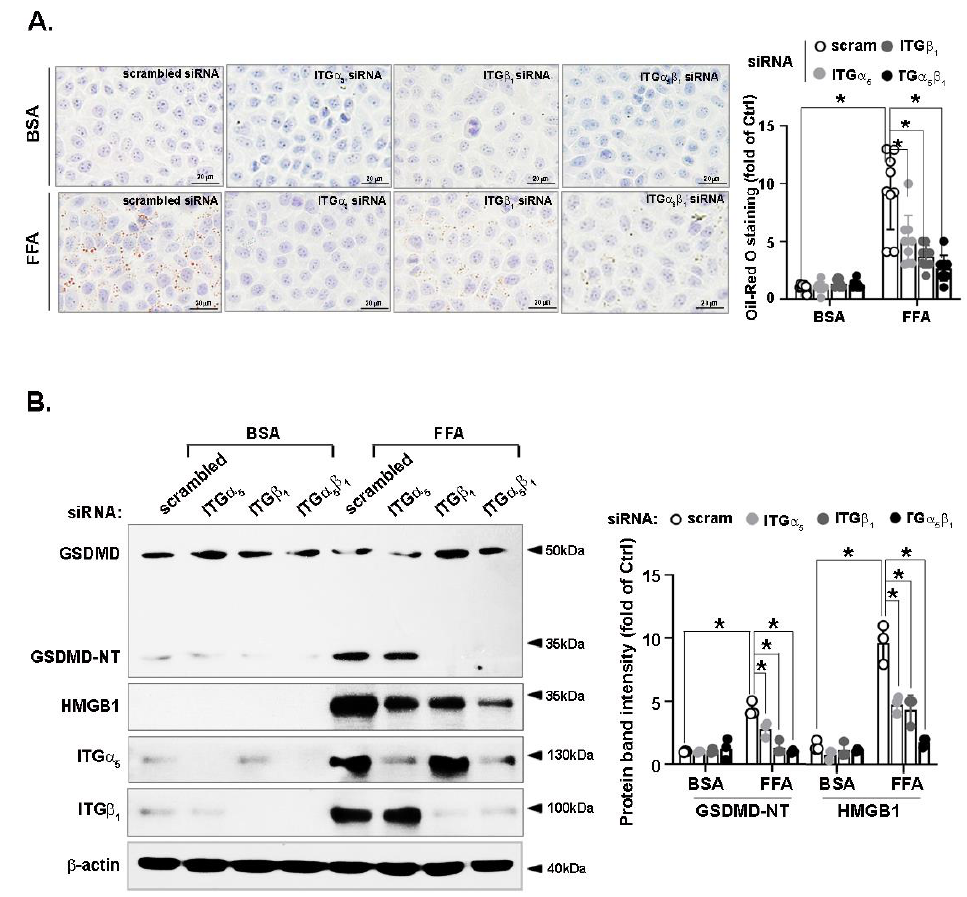
Figure 7. Effects of integrin α 5 β 1 on FFA-induced lipid accumulation and pyroptosis in hepatocytes. LO2 hepatocytes were transfected with scrambled, integrin α 5 , integrin β 1 , or integrin α 5 + β 1 siRNA, then incubated with FFA (1 mM). ( A ) Prior to harvest, LO2 hepatocytes were stained with oil red O for 1 h. Images shown are representative of three independent experiments performed in triplicate (left). The quantification of the lipid was performed after isopropanol extraction (right). ( B ) Protein levels of GSDMD, HMGB1, CCN1, and β -actin in the cell lysates were analyzed by immunoblotting. The immunoblots shown are representative of three independent experiments. Quantifications of band intensity were normalized to β -actin. * p < 0.05. ITG α 5 : integrin α 5 ; ITG β 1 : integrin β 1 .